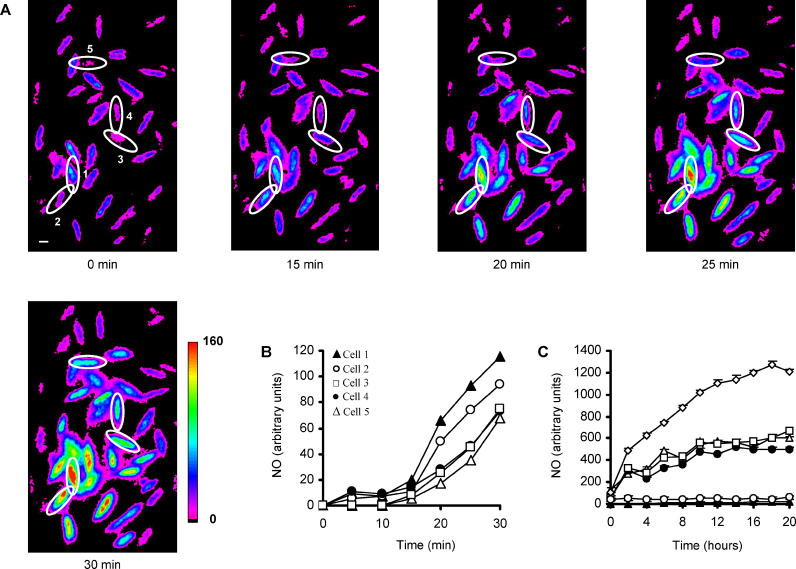
Intercellular Transmission of a DD-Derived Signal that Induces NO in Neighboring Cells(A and B) In vivo imaging of DD-induced NO burst in P. tricornutum cells.(A) Time course of NO production in single cells based on corresponding real-time movie (see Video S1).(B) Relative accumulation of NO in selected cells of the micrographs shown in (A).(C) NO accumulation in an untreated population of DAF-FM-loaded cells that were inoculated with a non DAF-FM–loaded population that had been exposed to DD at different concentrations (open circle, methanol solvent; open square, 660 nM; filled circle, 3.3 μM; open triangle 6.6 μM, and open diamond, 13.2 μM) for 24 h prior to the mixing. Incubation of fresh medium with 13.2 μM DD for 24 h (filled triangle) prior to addition to DAF-FM-loaded cells did not provoke any detectable increase in NO. Data in (C) are means plus standard deviation from four experiments.